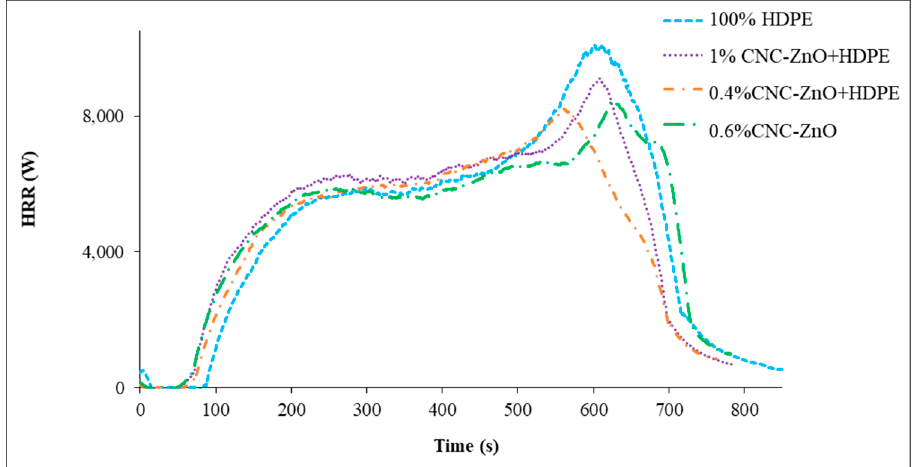
Figure 3. Heat Release Rate of HDPE and CNC-ZnO Formulations.